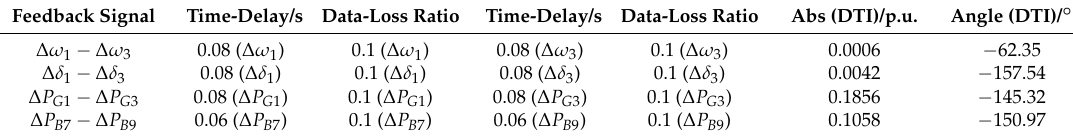
Table 1. Characteristics and DTI results of different feedback signals.